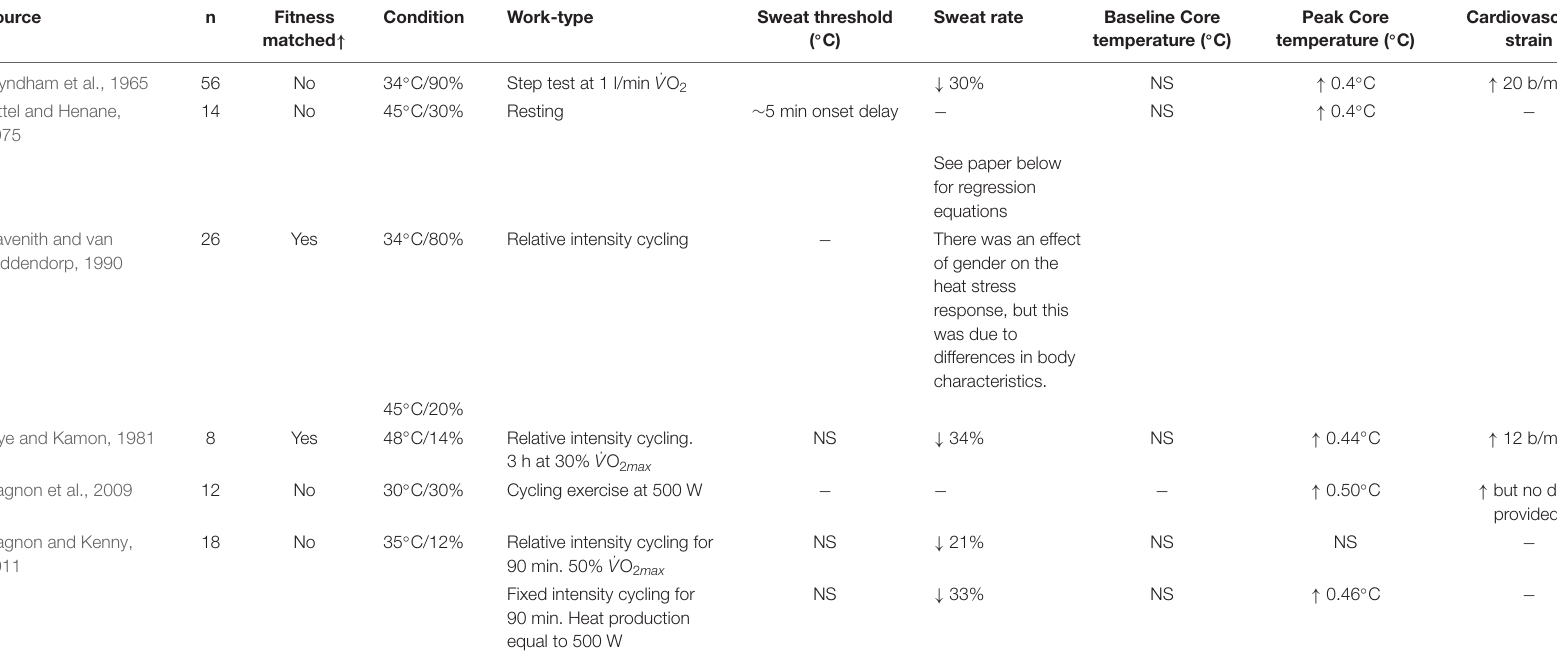
TABLE 8 | Overview of data relating to the heat stress responses in women when compared with men. Source n Fitness Condition Work-type Sweat threshold Sweat rate Baseline Core Peak Core matched ↑ ( ◦ C) temperature ( ◦ C) temperature ( ◦ C) Step test at 1 l/min ˙V O 2 ↓ 30% NS ↑ 0.4 ◦ C ↑ 20 b/min Resting ∼ 5 min onset delay − NS ↑ 0.4 ◦ C − See paper below for regression equations Relative intensity cycling − There was an effect of gender on the heat stress response, but this was due to differences in body characteristics. NS ↑ 12 b/min Cycling exercise at 500 W ↑ 0.50 ◦ C ↑ but no data provided. Relative intensity cycling for NS NS − 90 min. 50% ˙V O 2 max Fixed intensity cycling for NS ↓ 33% NS ↑ 0.46 ◦ C 90 min. Heat production equal to 500 W